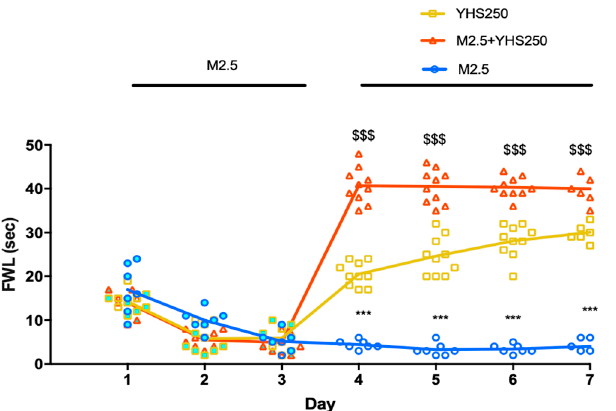
Figure 5. YHS reverses morphine tolerance. Analgesic response after 3 days (D) of Morphine, followed by 4 D of either YHS (250 mg/kg) or M2.5-M2.5+YHS (n = 10) (i.p. administration). Two-way ANOVA revealed significant drug effects F (6, 168) = 205.9 p < 0.0001, followed by Tukey’s multiple comparison test, *** p < 0.0001 M2.5 compared with M2.5-YHS and M2.5-M2.5-YHS on D4-7, $$$ p < 0.0001 compared M2.5-YHS with M2.5-M2.5-YHS on